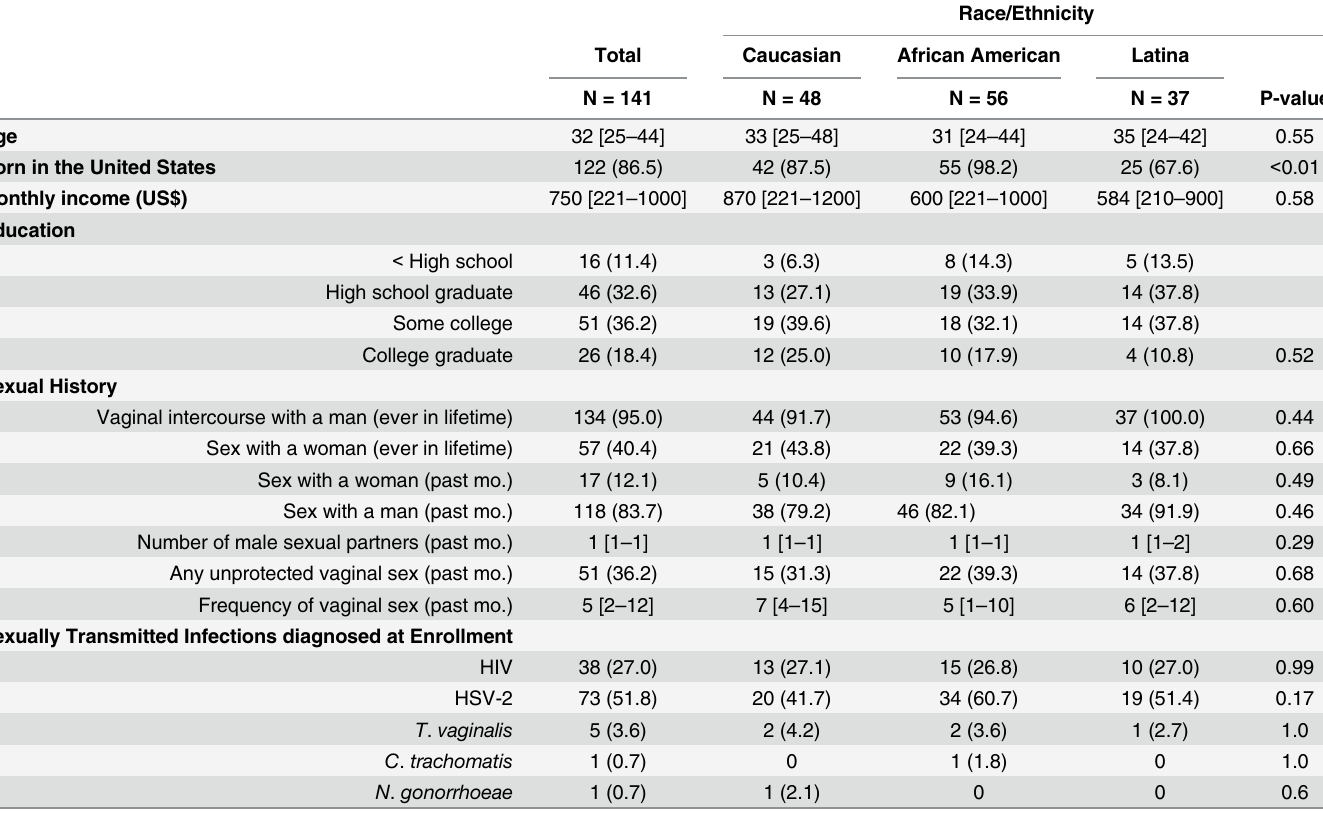
Table 1. Characteristics of participants measured at enrollment, by